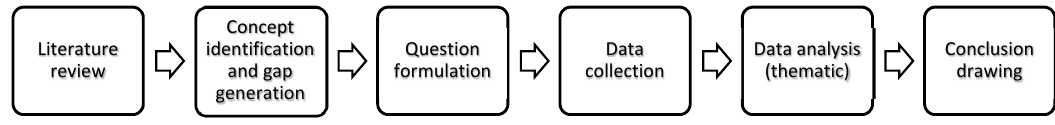
Figure 1. Research